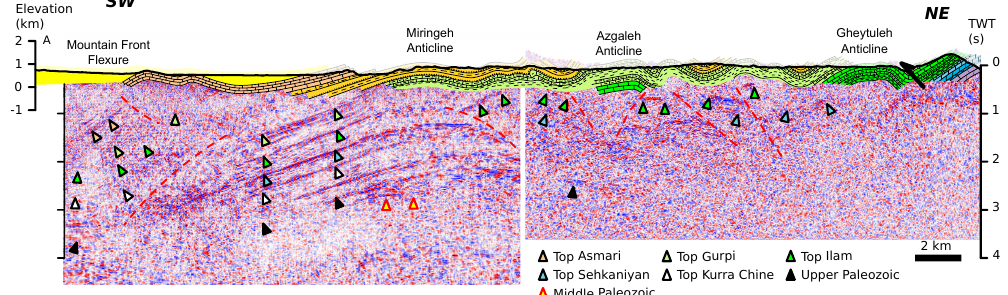
Figure 5. SW part of the NE–SW-oriented geological section across the hypocentral area. Near vertical seismic profiles are displayed below the cross section (vertical scale is roughly equal to the horizontal scale).